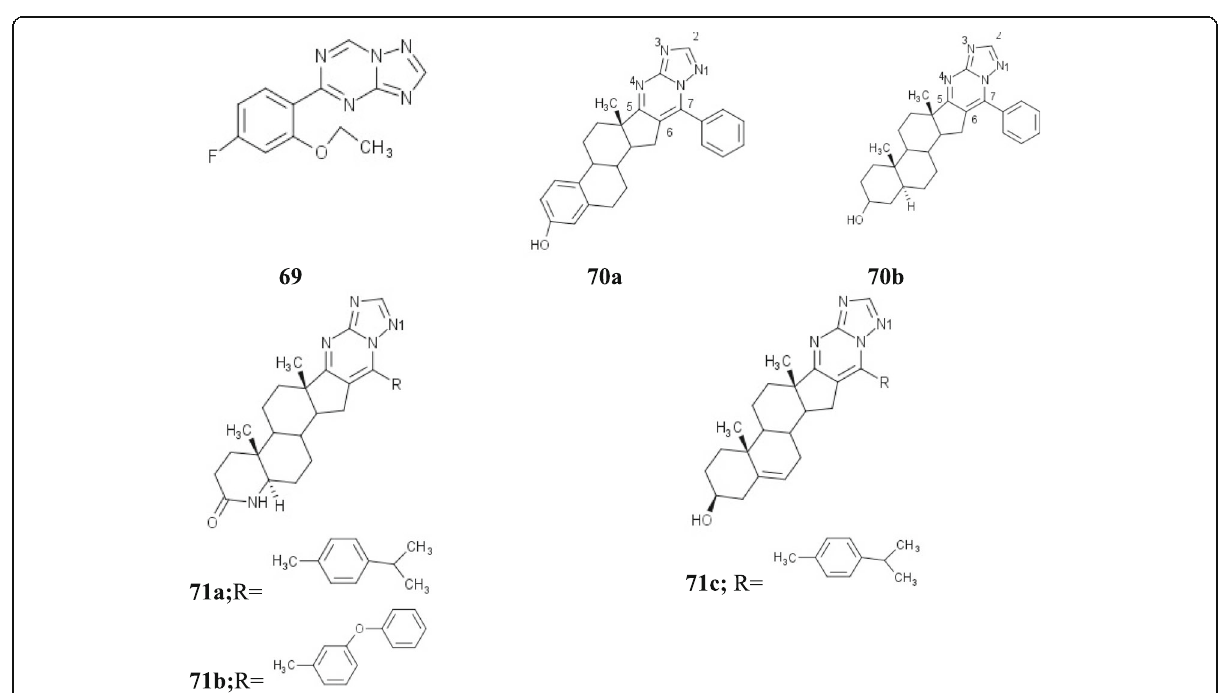
Fig. 23 Chemical structure of triazolo pyrimidines